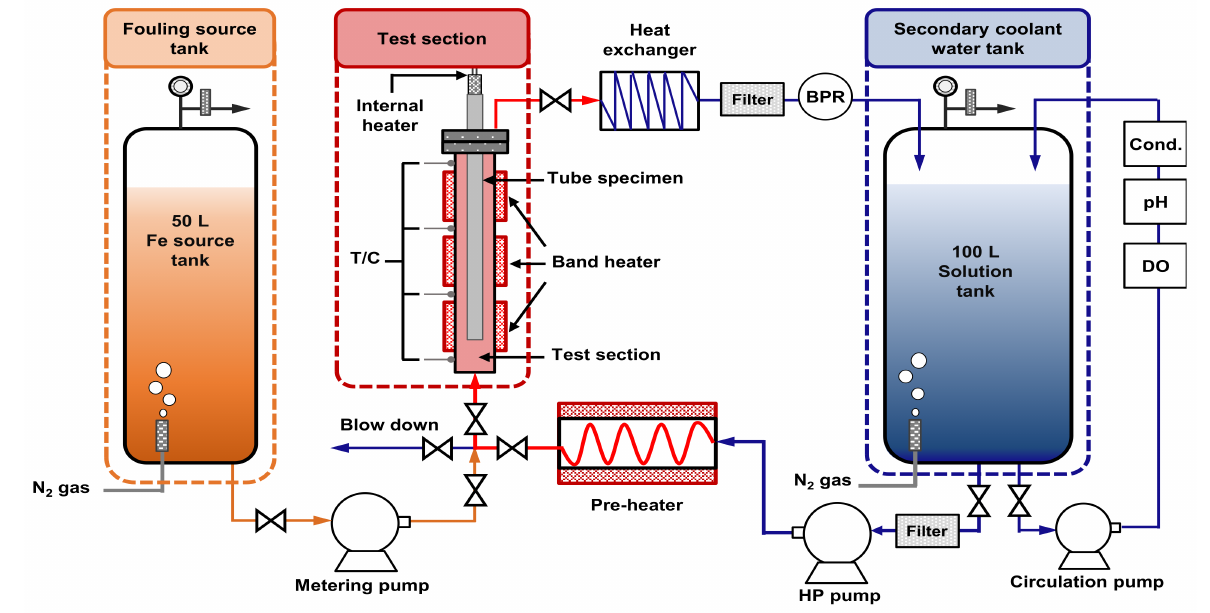
Figure 2. Schematic diagram of a magnetite deposition loop system for simulating secondary water conditions.